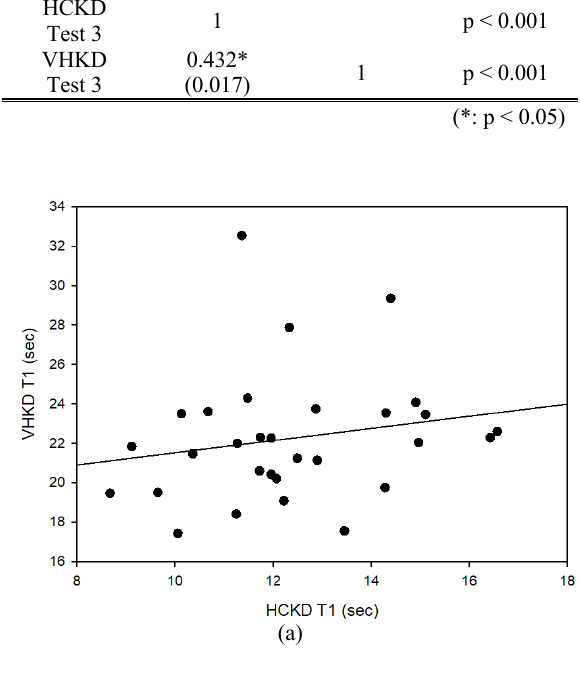
Correlation between HCKD and VHKD (Test 3) variable